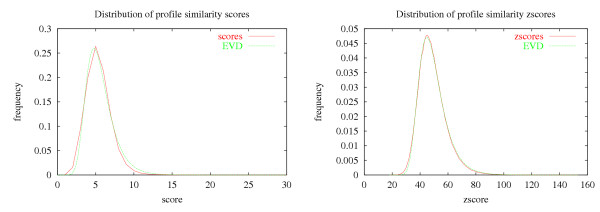
Distribution of profile similarity scores. (a) The uniform approach: the scores follow the EVD distribution (with λ = 0.707 and u = 4.77. (b) The normalized length-corrected scores (zscores) also follow the EVD (zscores are shifted and multiplied by 10 to emulate typical values for raw similarity scores).